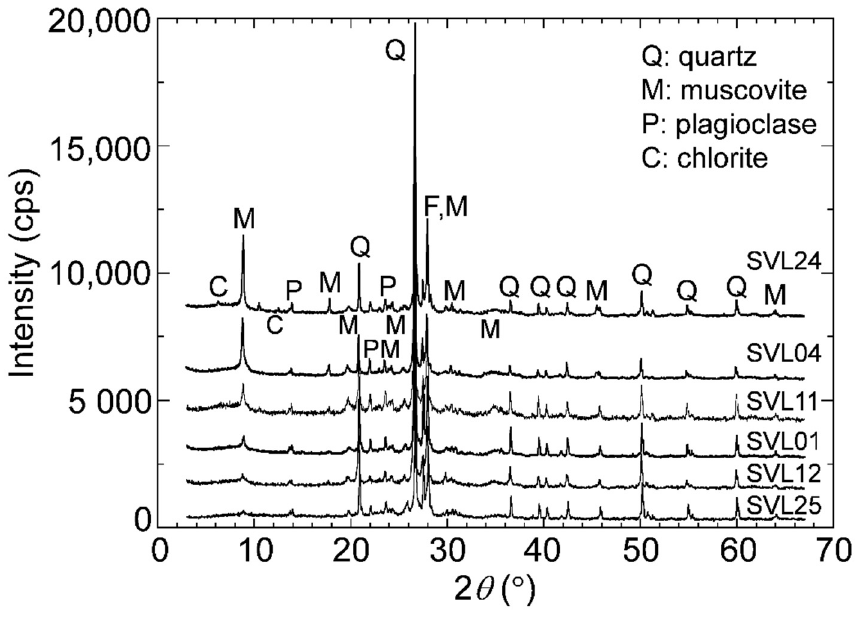
Figure 6. XRD patterns of pottery samples (SVL01, SVL04, SVL11, SVL12, SVL24, and